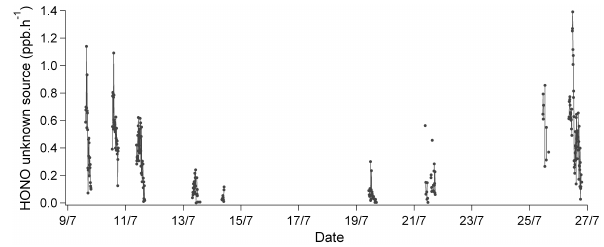
Fig. 9. Evolution of the calculated unknown HONO source in ppbh − 1 (Eq. 4) during the MEGAPOLI summer campaign.